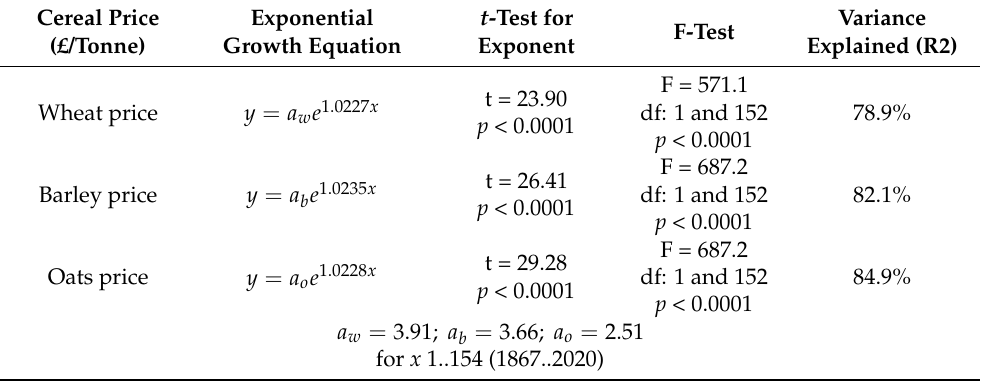
Table 1. Regression models for prices of cereals